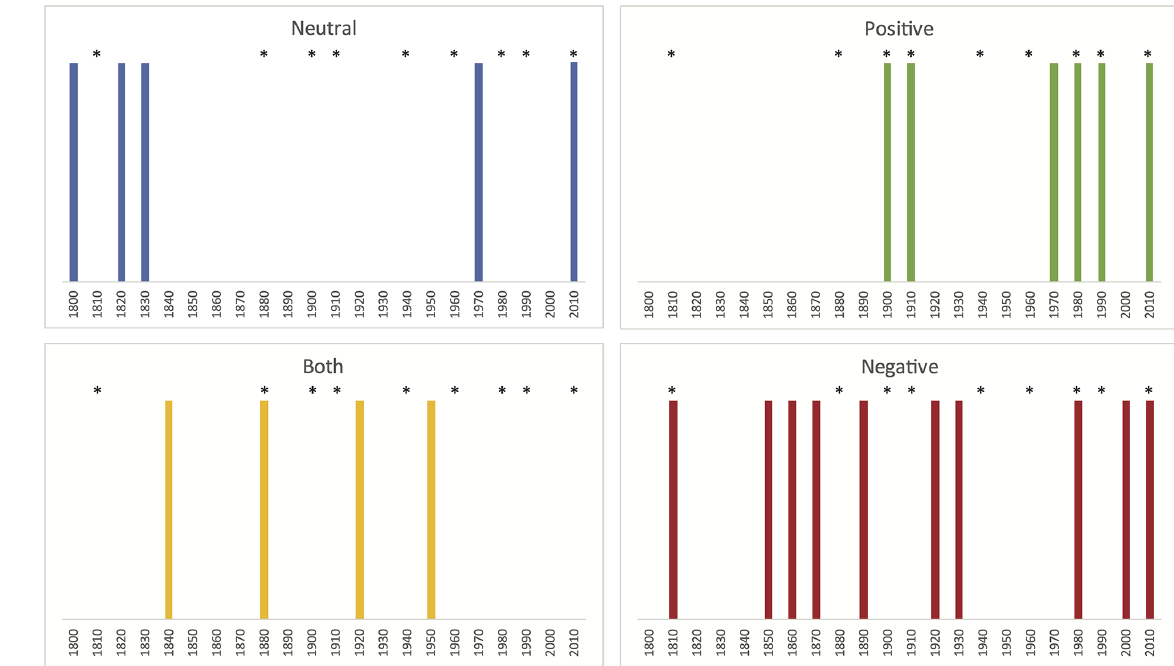
Figure 1. Connotations (neutral, positive, negative, or both) of the considered poems, arranged chronologically and aggregated by decade. Asterisks indicate major eruptions (as shown in Table